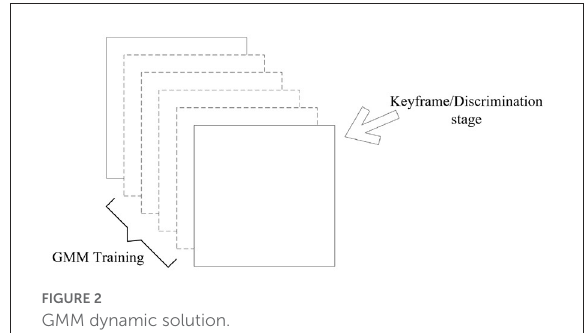
FIGURE2 GMM dynamic solution.